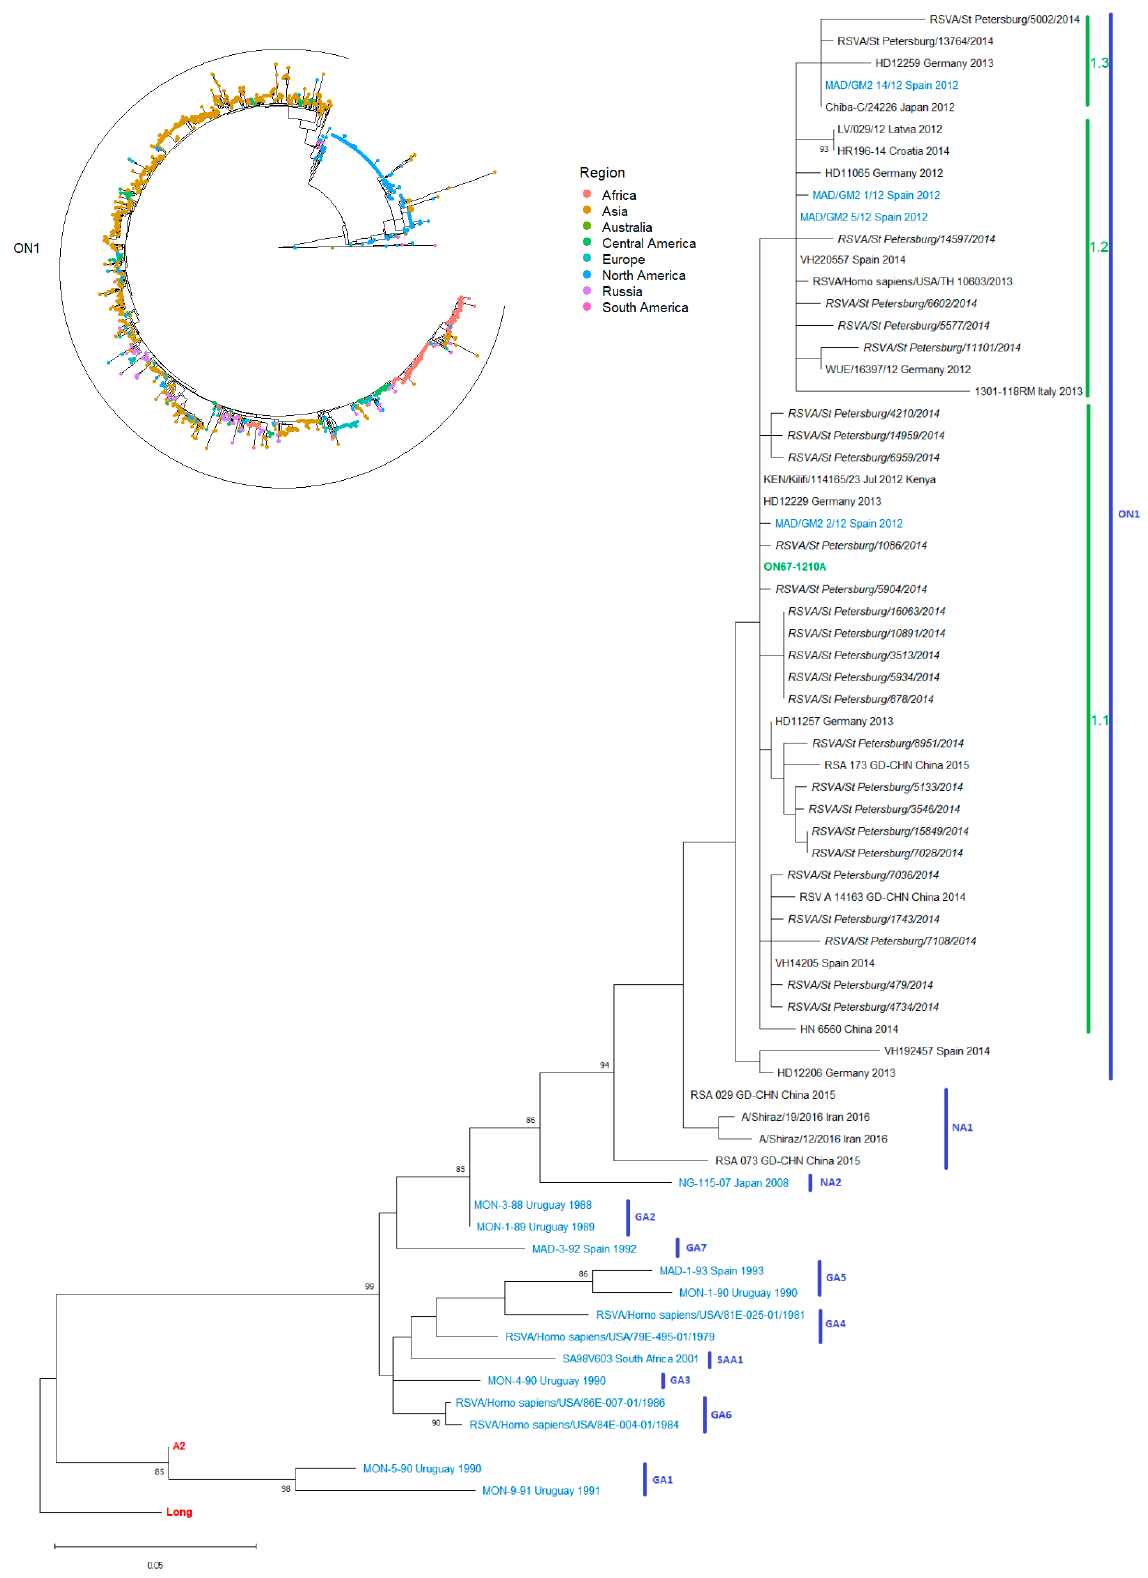
Figure 1. Phylogenetic trees by G gene sequence, St. Petersburg RSV-A isolates, 2013–2014 epidemic season. Radial tree (1491 sequences from GenBank) with a focus on geographic distribution. Rectangular tree with reference strains for each genotype colored in blue; original Canadian reference virus (ON67-1210A)—green; progenitors of RSV-A (Long and A2 strains) colored in